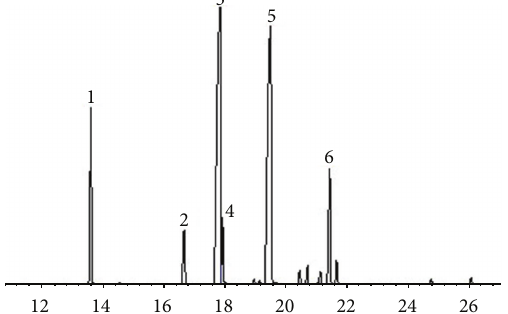
Figure 4: Typical chromatogram of fatty acid methyl ester prepared from EAEPO before heating. Peaks: 1: hexadecanoic acid; 2: octade- canoic acid; 3: 9-octadecenoic acid; 4: 9-octadecenoic acid; 5: 9,12-